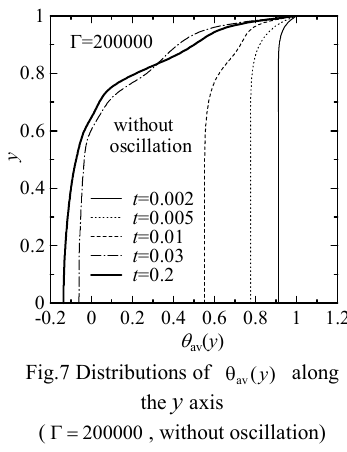
Fig.6 Distributions of